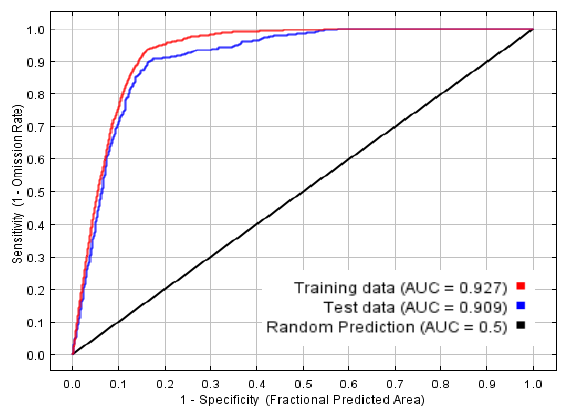
Figure 3. Training and test AUC plot to measure performance of model against first set of data